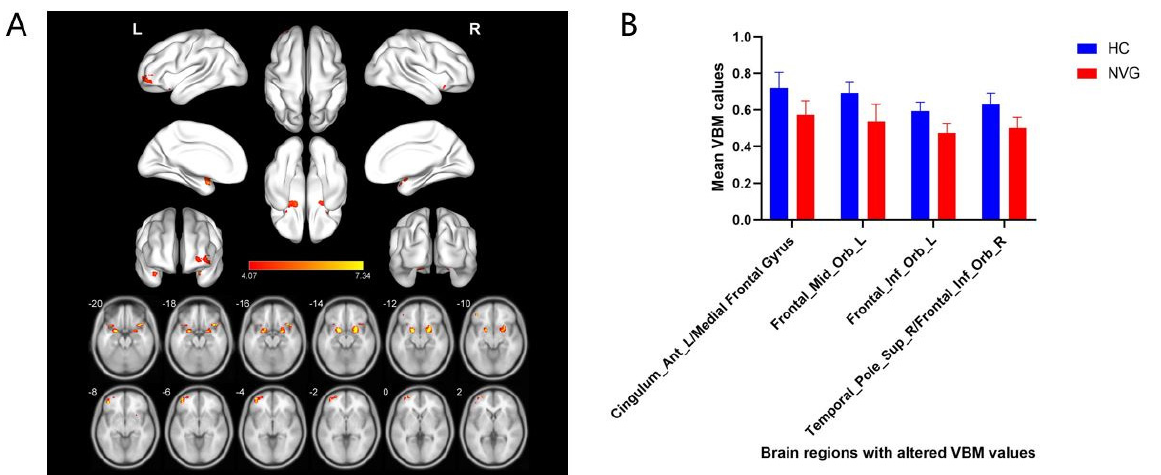
Fig. 2. Spontaneous brain activity in NVG patients. The two groups of brain regions show statistically significant differences in terms of VBM. (A) Patients presented alternated VBM valued in Cingulum Ant L/Medial Frontal Gyrus, Frontal Mid Orb L, Frontal Inf Orb L, Temporal Pole Sup R/Frontal Inf Orb R compared with that reported in the HC group, the red areas indicate the variable VBM values. (B) The mean GMV values of two groups. VBM, voxel-based morphometry; NVG, neovascular glaucoma; Cingulum Ant L, left anterior cingulum; Frontal Mid Orb L, left middle frontal gyrus, orbital part; Frontal Inf Orb L, left inferior frontal gyrus, orbital part; Temporal Pole Sup R, right temporal: superior temporal gyrus; Frontal Inf Orb R, right frontal inferior orbital part; HC, healthy controls.